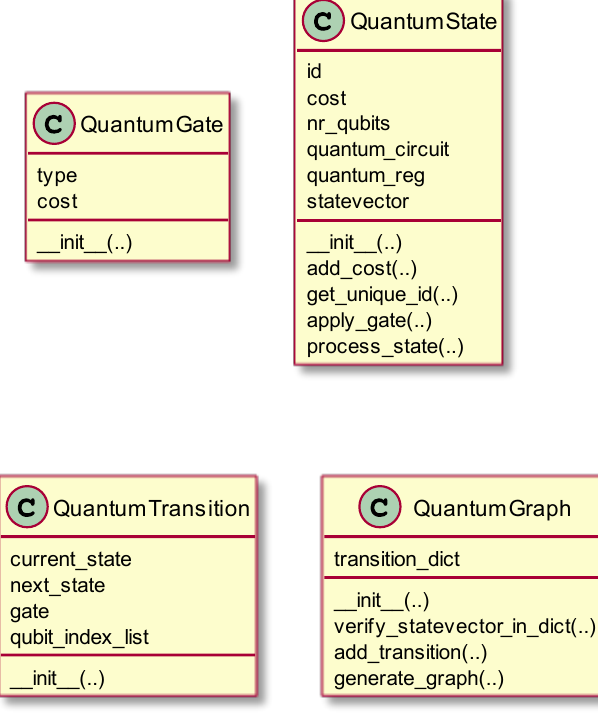
Figure 2. UML Class diagram of the project.